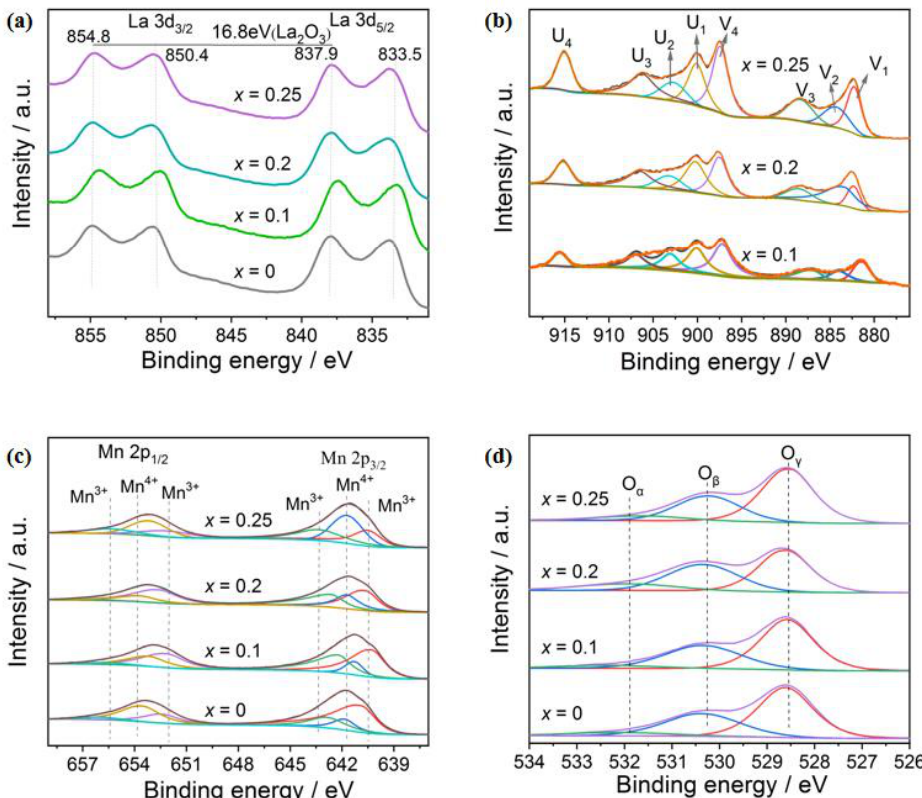
≤ x ≤ 0.25): ( a ) La 3d; ( b ) Ce 3d; ( c ) Mn 2p; ( d ) O Figure 5. XPS spectra of La 1- x Ce x MnO 3 (0 ≤ x ≤ 0.25) : ( a ) La 3d; ( b ) Ce 3d; ( c ) Mn 2p; ( d ) O 1s. Figure 5. XPS spectra of La 1- x Ce x MnO 3 (0